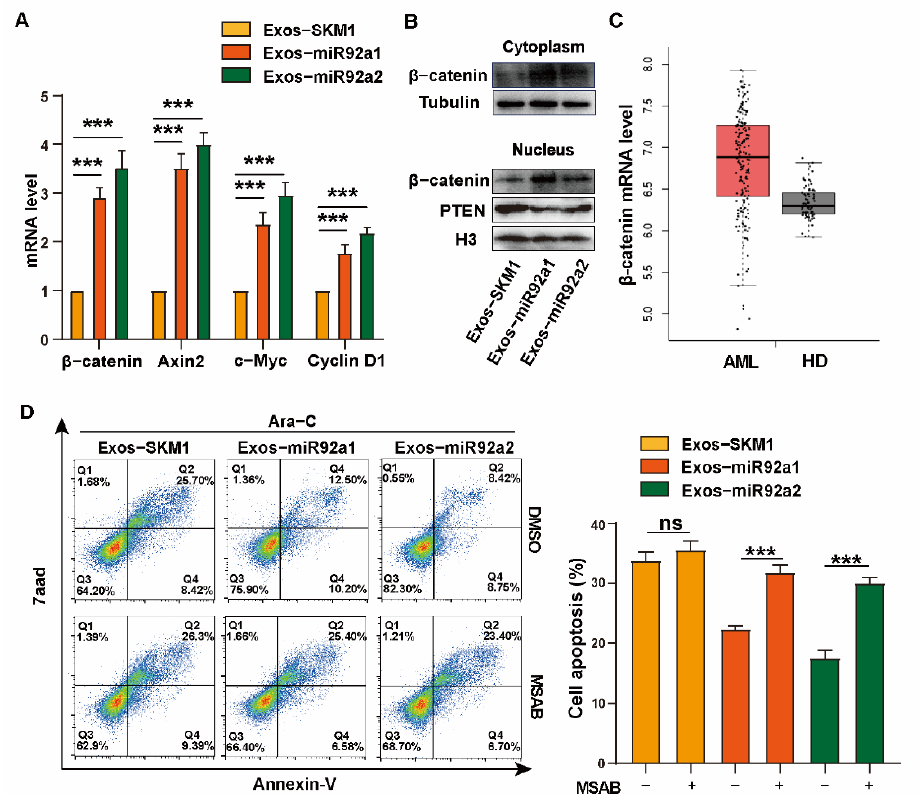
Figure 4. miR92a regulates cell growth via activating Wnt/ β -catenin signal. ( A ) Expression of β -catenin, Axin2, c-Myc and Cyclin D1 in Exos-SKM1-, Exos-miR92a1-, and Exos-miR92a2-treated SKM1 cells analyzed by qRT-PCR. ( B ) β -catenin level in cytoplasm and PTEN and β -catenin in nucleus in Exos-SKM1, Exos-miR92a1, and Exos-miR92a2-treated SKM1 cells analyzed by Western Blotting. ( C ) TCGA analysis of β -catenin level in AML. ( D ) Apoptosis of Exos-SKM1-, Exos-miR92a1-, and Exos-miR92a2-treated SKM1 under 2.5 µ M MSAB and 2 µ M Ara-C treatment for 48 h, respectively, ns ≥ 0.05, *** p <